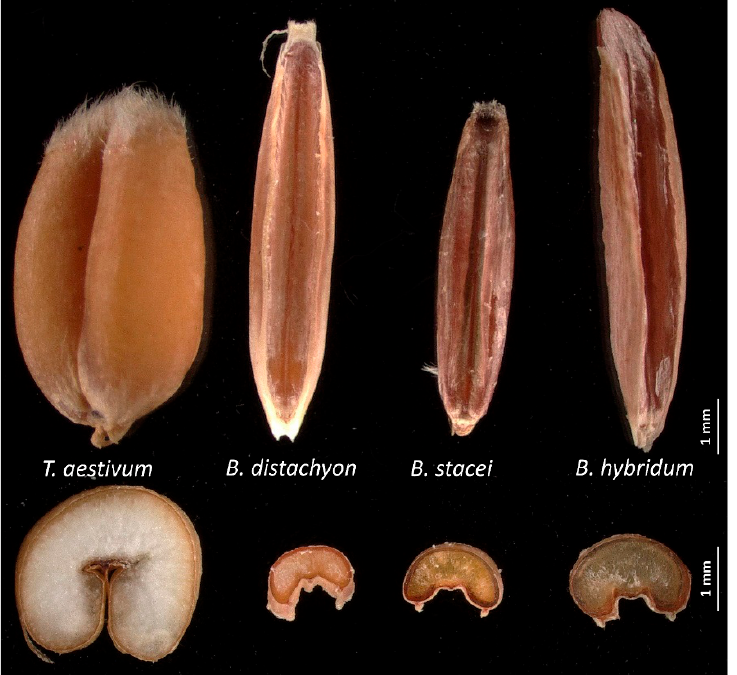
Figure 1. Grains of Brachypodium species Brachypodium distachyon Bd21 (Bd), Brachypodium stacei ABR114 (Bs) and Brachypodium hybridum ABR113 (BdBs) compared to wheat ( Triticum aestivum ). Images were from (top) grains where the lemma had been removed and (bottom) transversely sections from seeds. Note the large starchy endosperm in wheat that is greatly diminished in each Brachypodium species. Scale bars represent 1 mm.